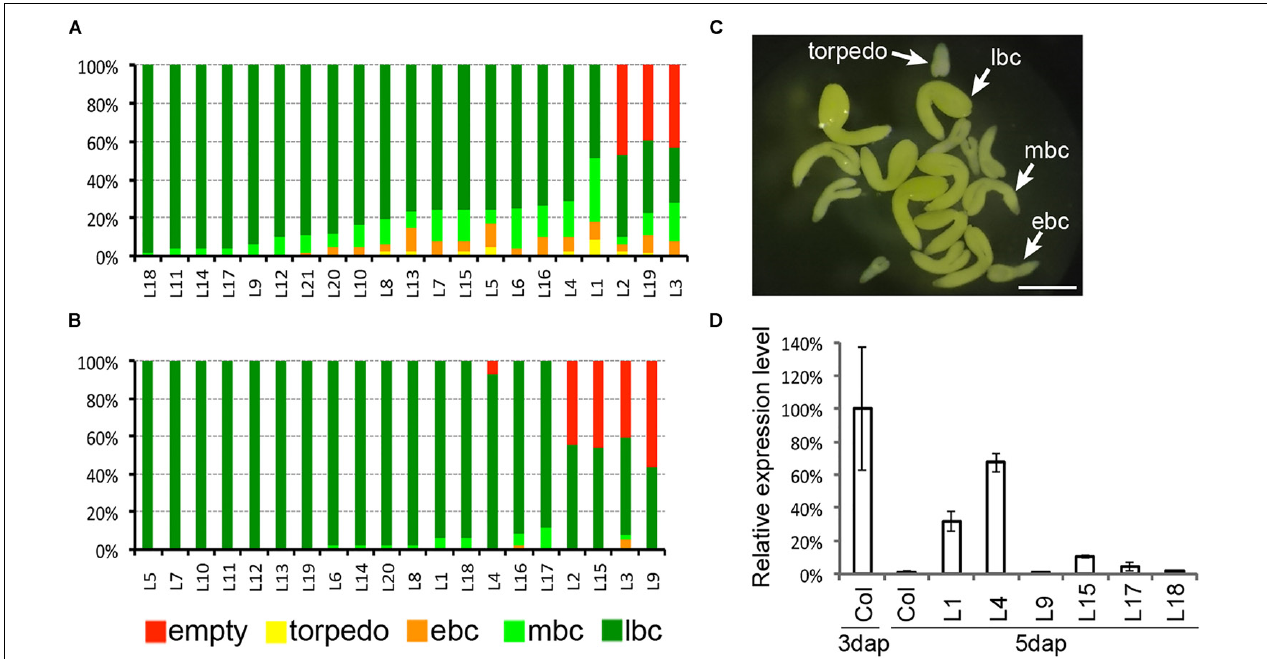
FIGURE 4 | Prolonged expression of InvINH1 delayed embryo growth. (A) The embryo phenotype of 21 individual T1 plants carrying pZOU-InvINH1 transgene . (B) The embryo phenotype of 20 individual T1 plants carrying pZou transgene. (C) Dissected embryos from the same silique of a T1 plant carrying pZOU-InvINH1 . (D) Ectopic expression of InvINH1 in pZOU-InvINH1 transgenic plants. The InvINH1 mRNA level in whole siliques was determined by qRT-PCR at 5 dap. The expression level in wild-type (Col-0) siliques at 3 dap was used as a reference point (100%) to calculate the relative expression level in other samples. Around 50–60 seeds were dissected per line to determine the embryo phenotype. empty, undeveloped ovules; ebc, early-bent-cotyledon stage; mbc, mid-bent-cotyledon stage; lbc, late-bent-cotyledon stage (lbc). Bar = 500 µ